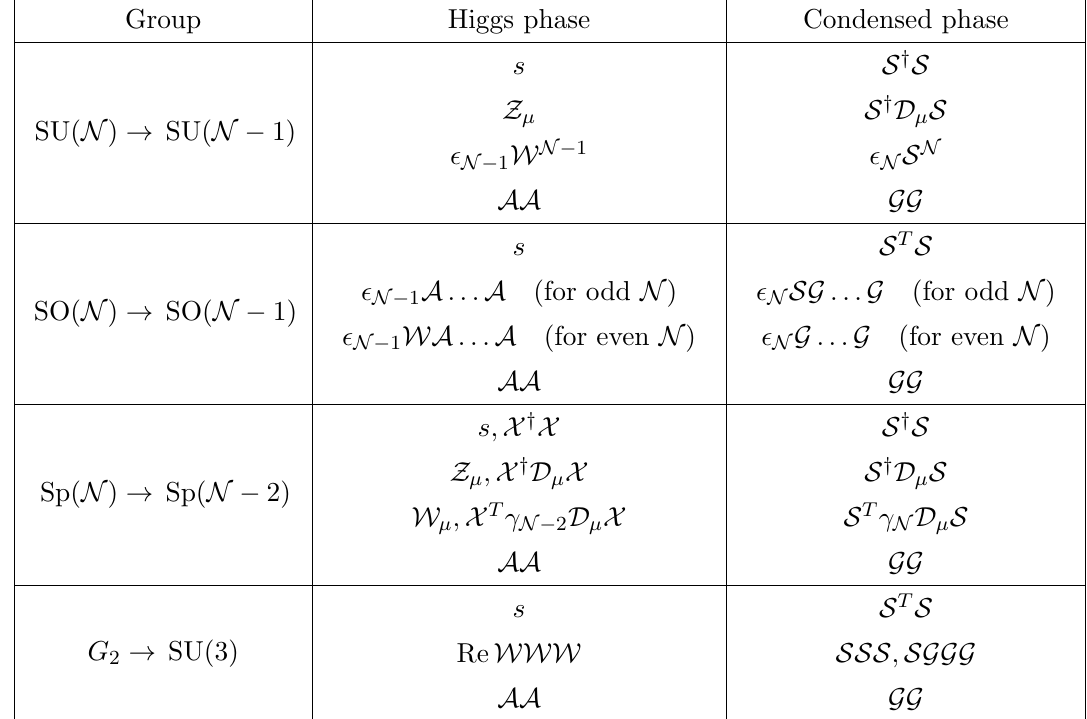
Table 1 . Correspondence of the asymptotic states between the Higgs and con(cid:12)ned phases.